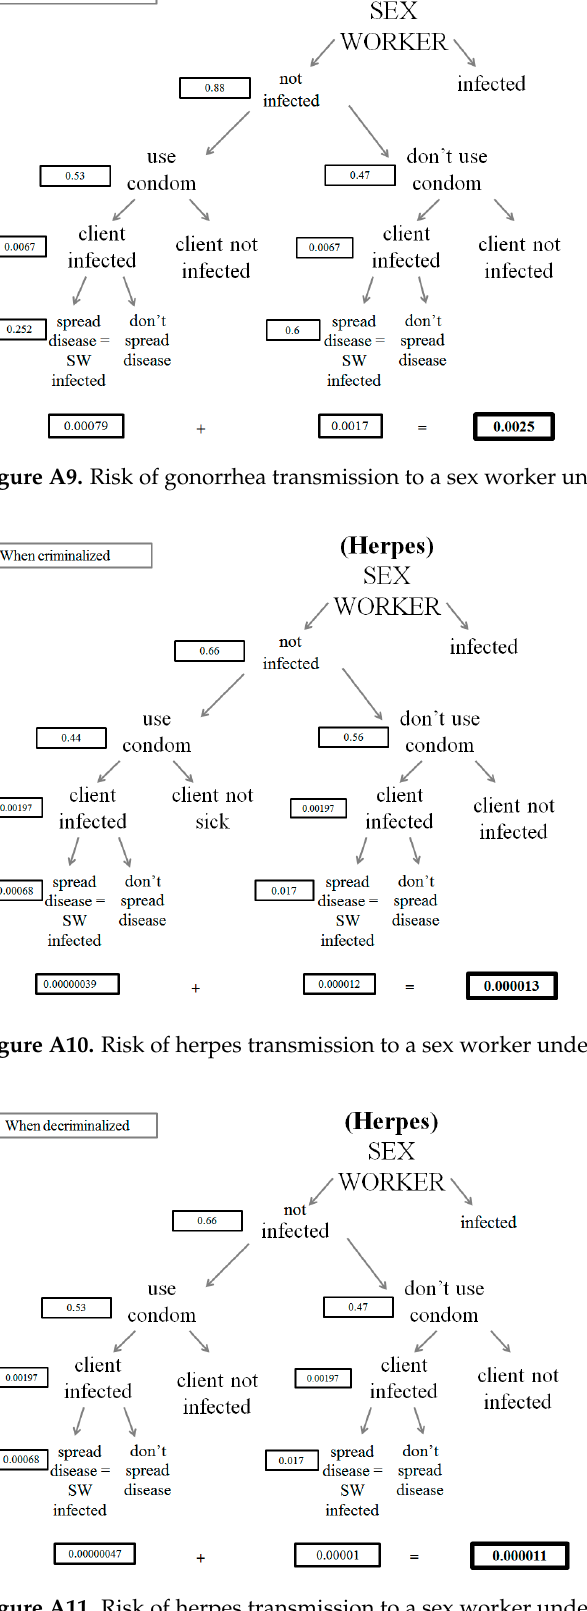
Figure A11. Risk of herpes transmission to a sex worker under decriminalization.